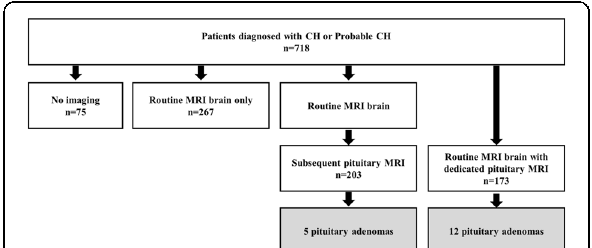
Fig. 1 (abstract P149). Flow diagram showing patient disposition throughout the trial